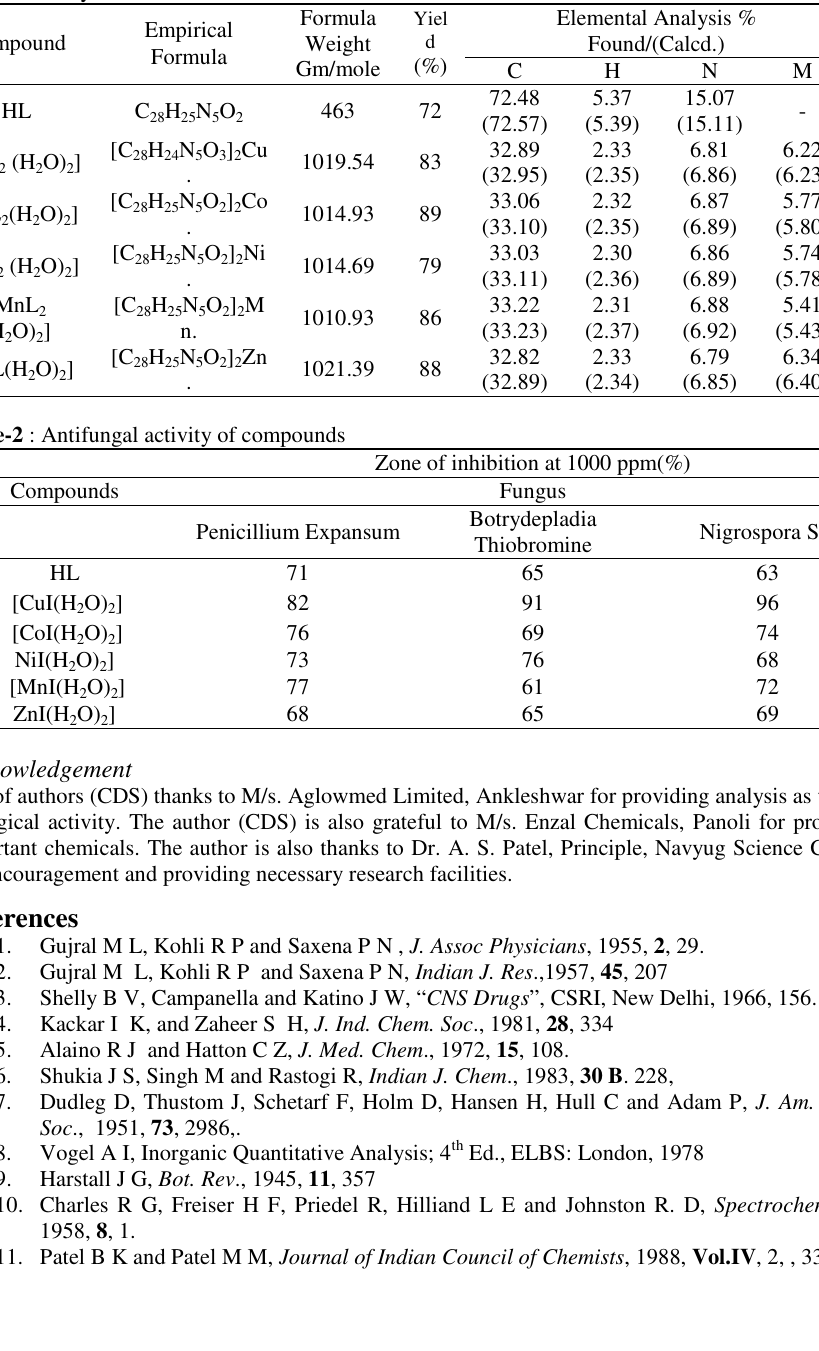
Table-1 Analytical Data of the coordination metal chelats of HL